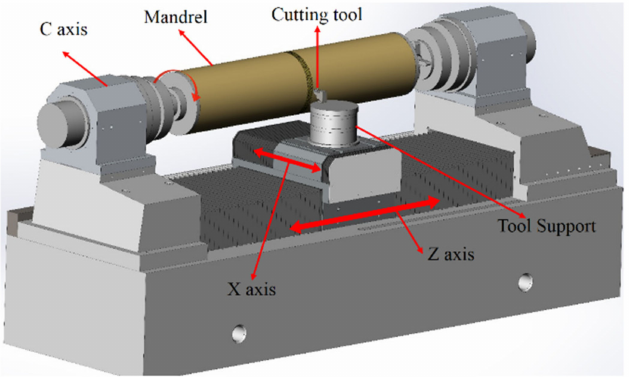
Figure 1. Structure layout of the mandrel ultra-precision machine